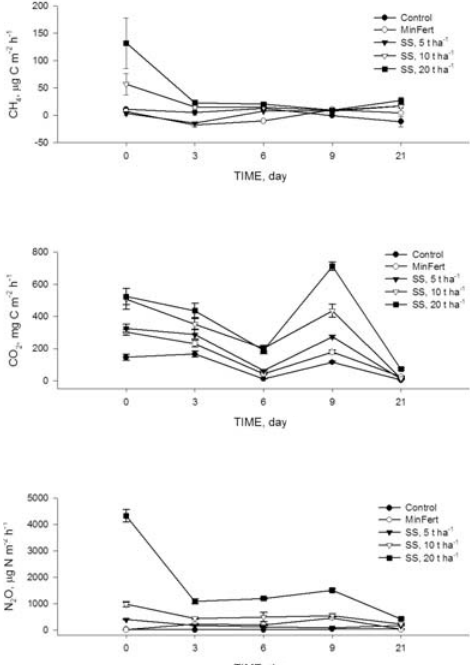
Figure 2. CH , CO and N O fluxes in Ultisol treated 4 2 2 with sewage sludge and mineral fertilizer planted with castor beans. MinFert = Mineral fertilizer application, SS = Sewage-Sludge application. Vertical bars represent average standard deviation (n =